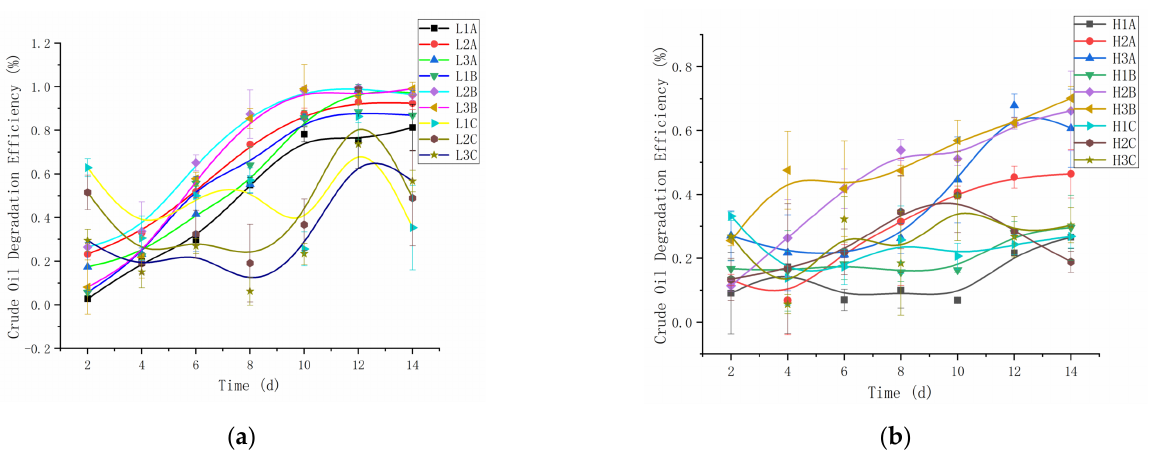
Figure 1. Biodegradation efficiency of crude oil treated with different nutrient concentrations within 14 days. ( a ) Seawater degradation efficiency of 0.01 g/L crude oil ( b ) Seawater degradation efficiency of 10.00 g/L crude oil.